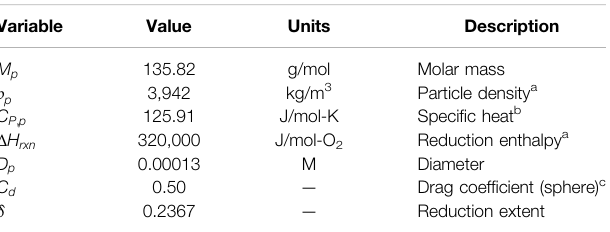
TABLE 1 | CAM28 particle